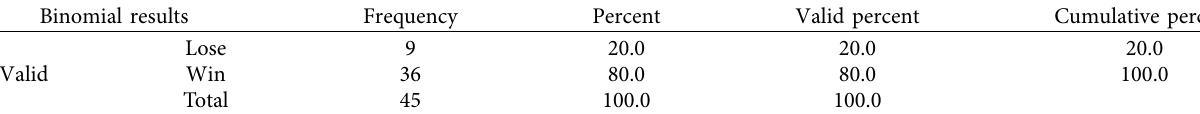
Table 4: Table of frequency of win and lose mode (for and against) system output.